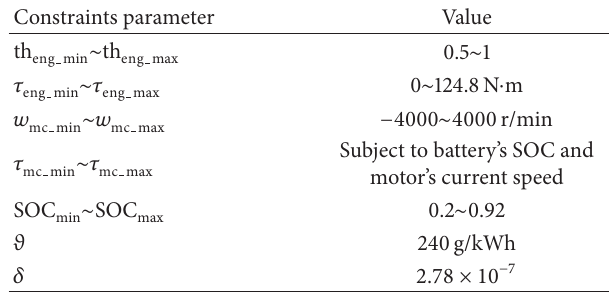
Table 1: Components’ parameters of a PHHE.